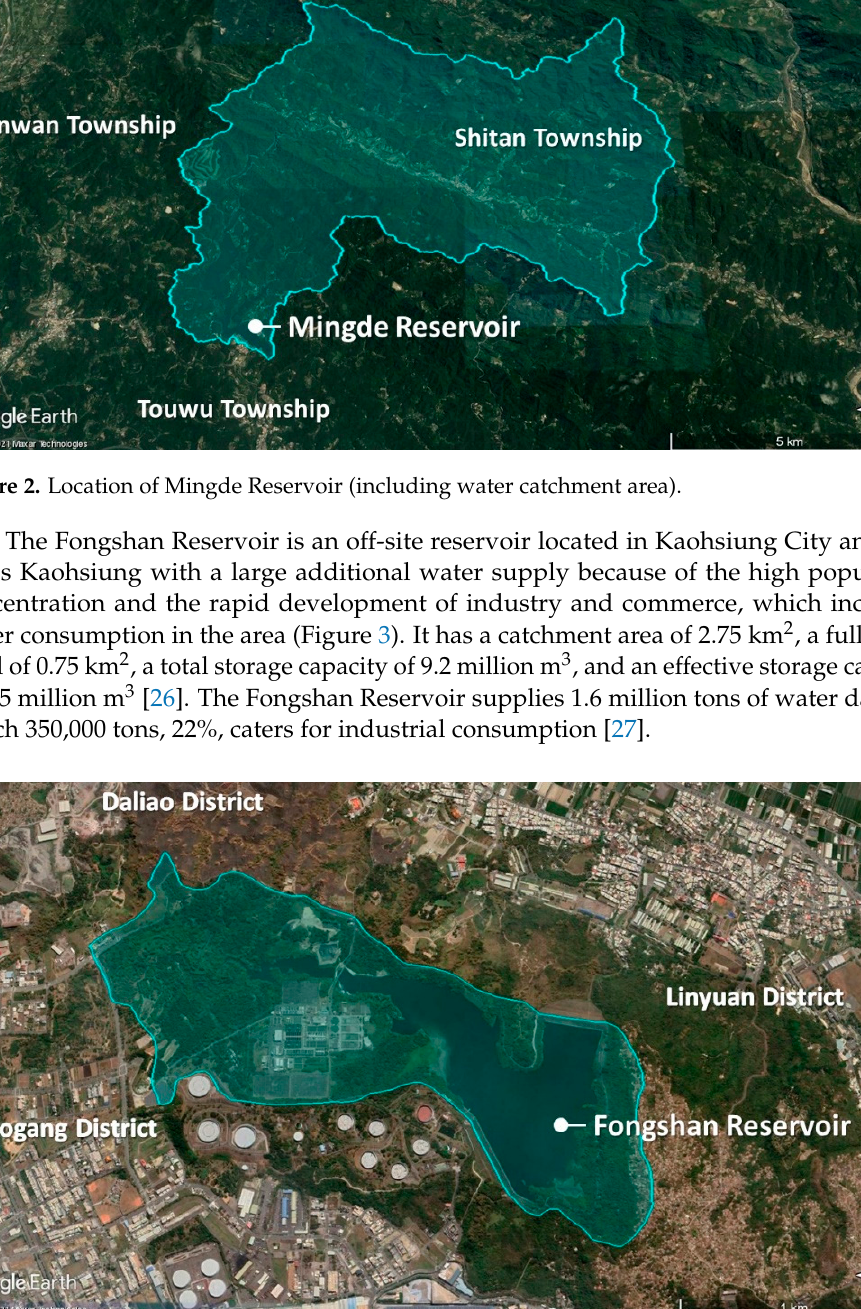
Figure 3. Location of Fongshan Reservoir (off-stream).